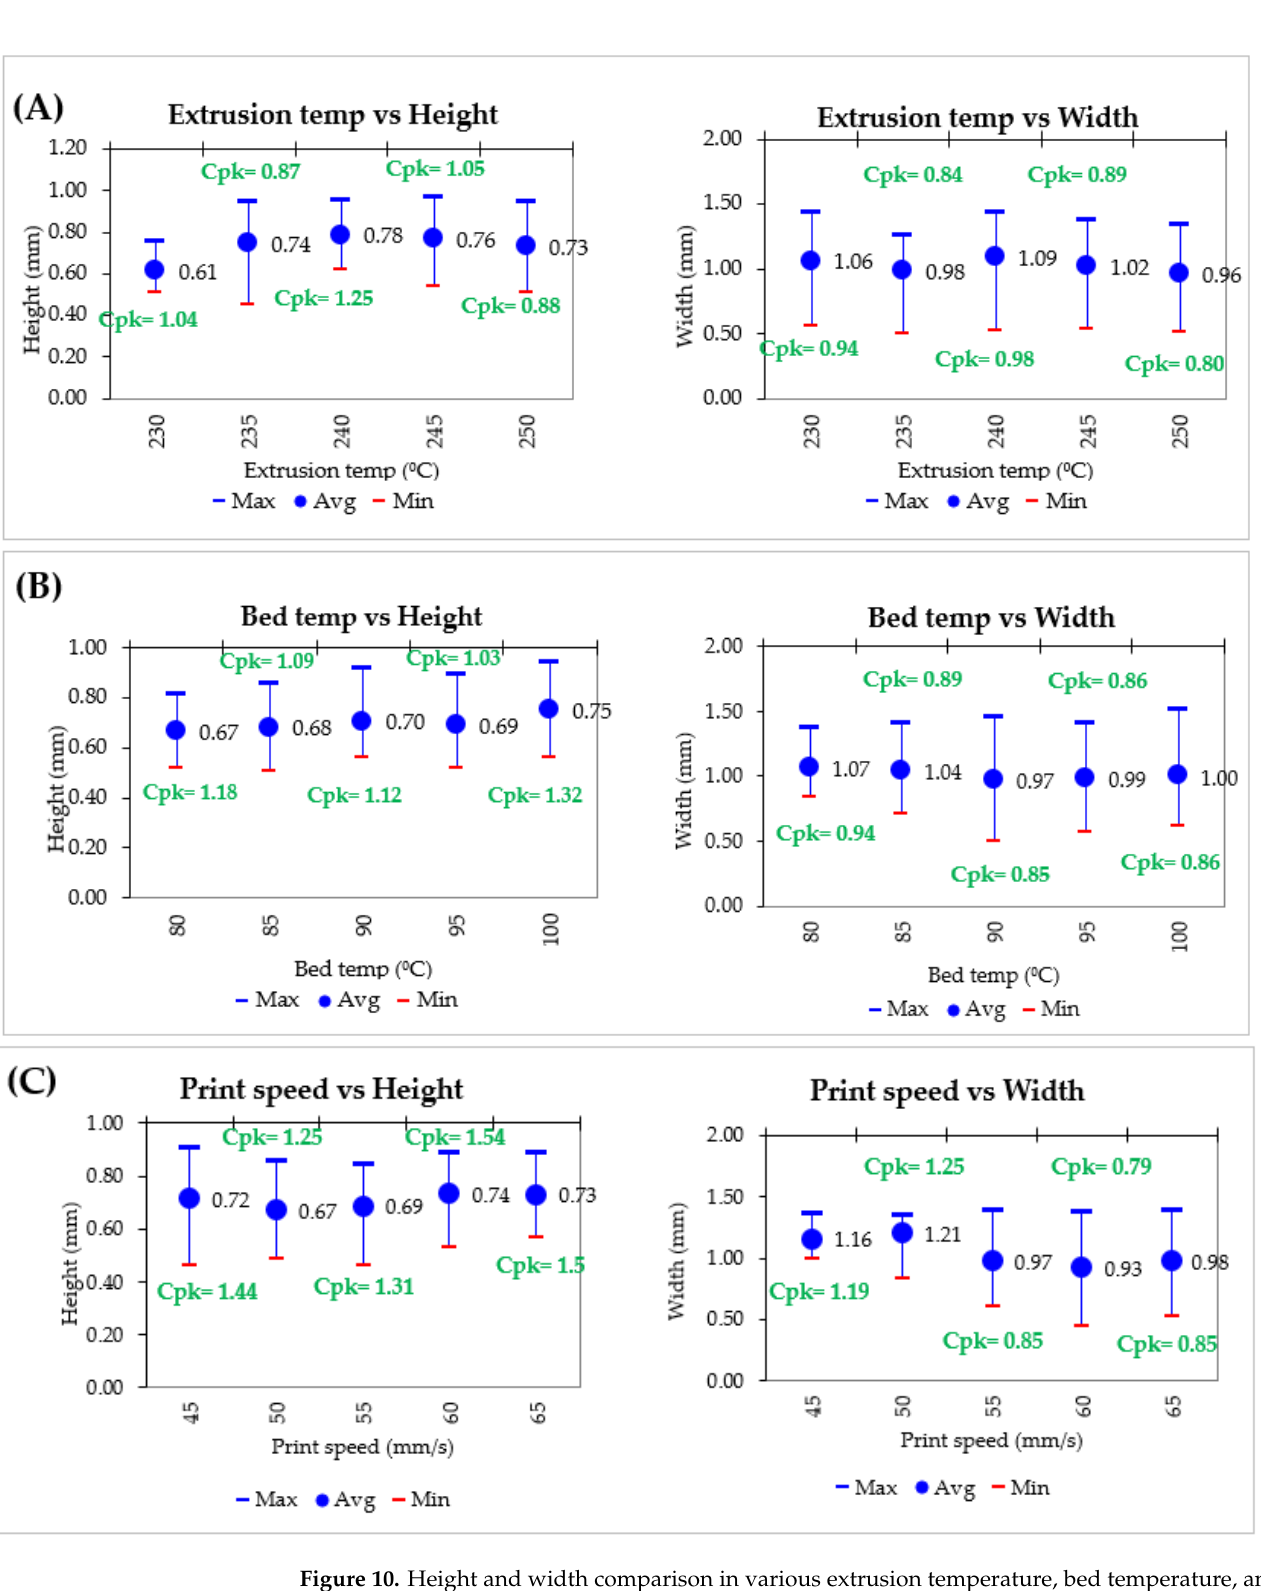
Figure 10. Height and width comparison in various extrusion temperature, bed temperature, and print speed.